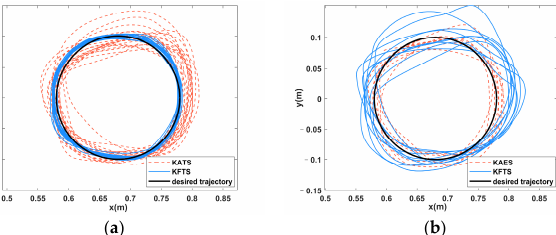
Figure 16. ( a ) Comparison chart of actual trajectory of S1 in training stage. ( b ) Comparison chart of actual trajectory of S1 in the evaluation stage.